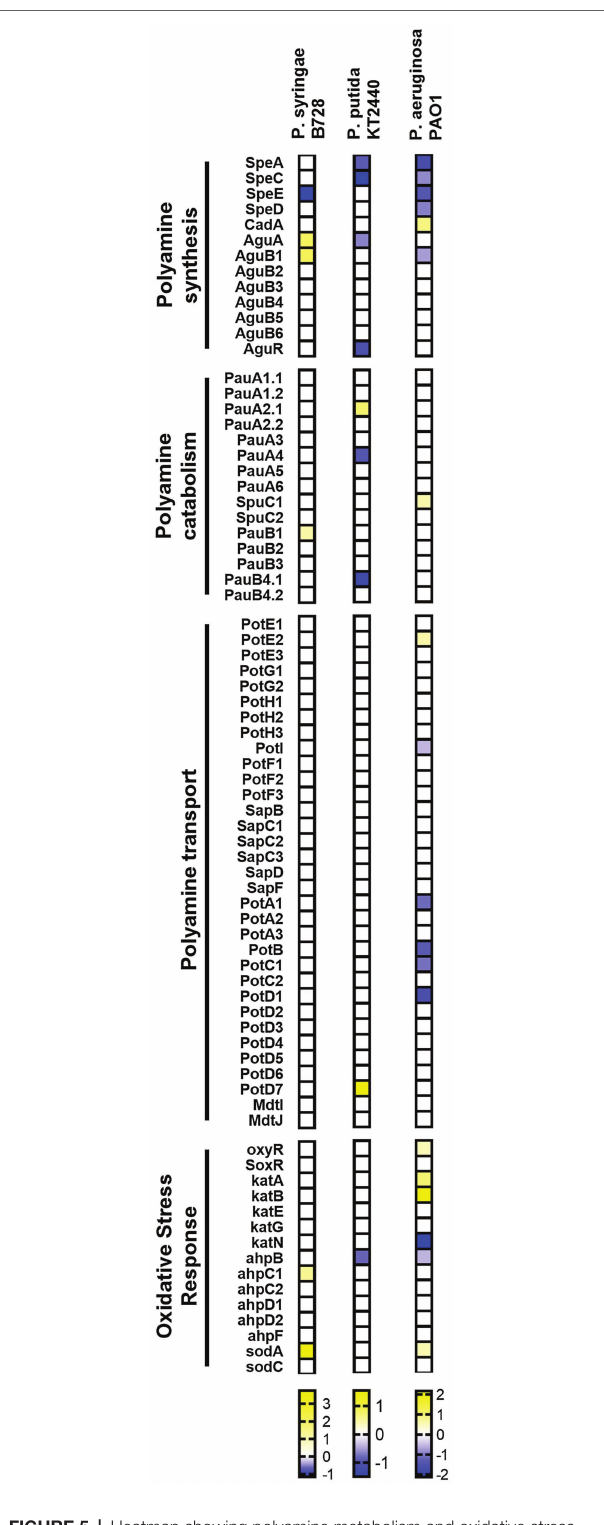
FIGURE 5 | Heatmap showing polyamine metabolism and oxidative stress gene expression in Pseudomonas species during exposure to H 2 O 2 in comparison to basal conditions. Color scales represent expression levels reported by the authors of indicated references. Gene expression levels were considered if log 2 FC > |0.5| and p adj <